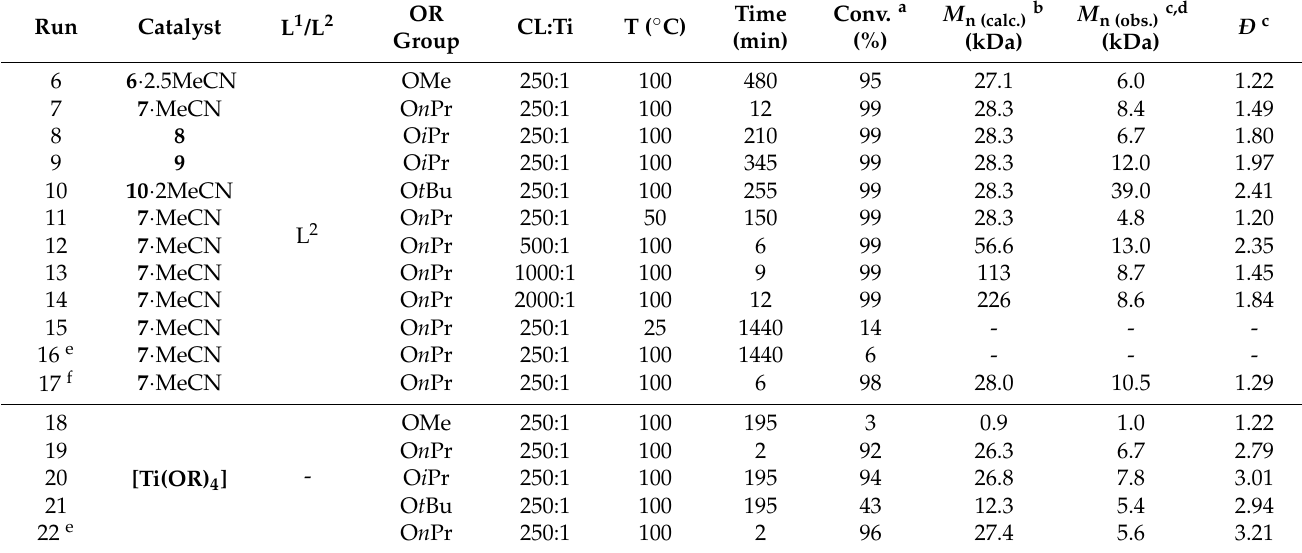
Reaction conditions: ε -CL 4.5 mmol, toluene 2 mL, N 2 atmosphere. a Determined by 1 H NMR spec- troscopy on the crude reaction mixture. b Calculated from [CL]/[Ti] × Conv. × M (CL) + M(end group). c From GPC. d Values corrected considering Mark – Houwink factor (0.56) from polystyrene stand- ards in THF. e Reaction conducted in air. f Conducted under solvent-free conditions.